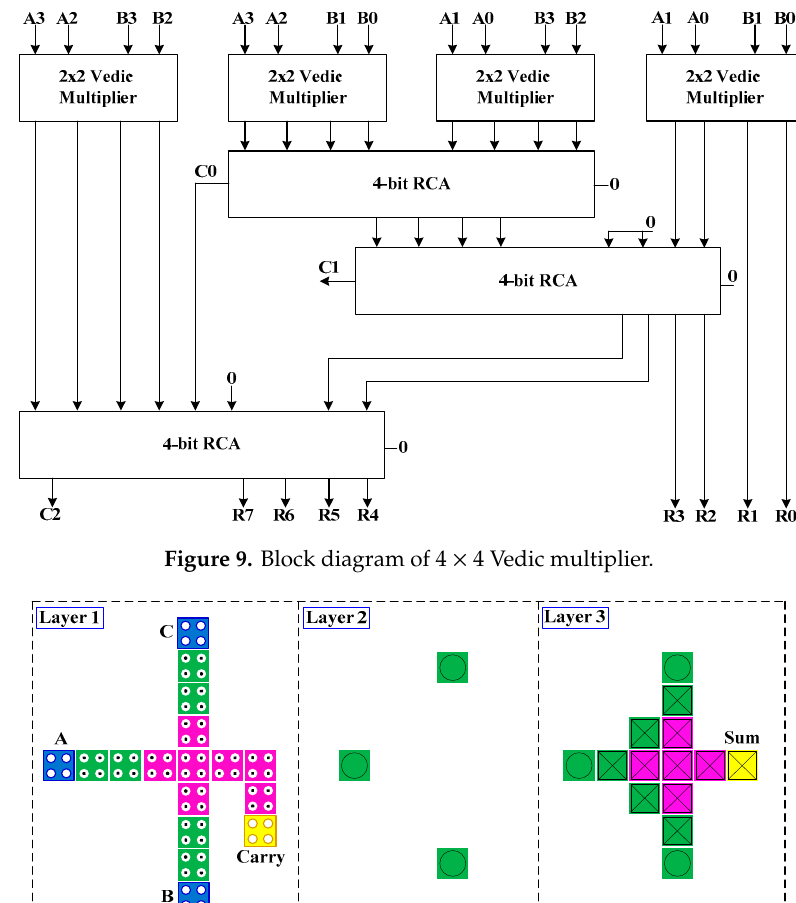
Figure 10. Full adder for designing ripple carry adder (RCA).